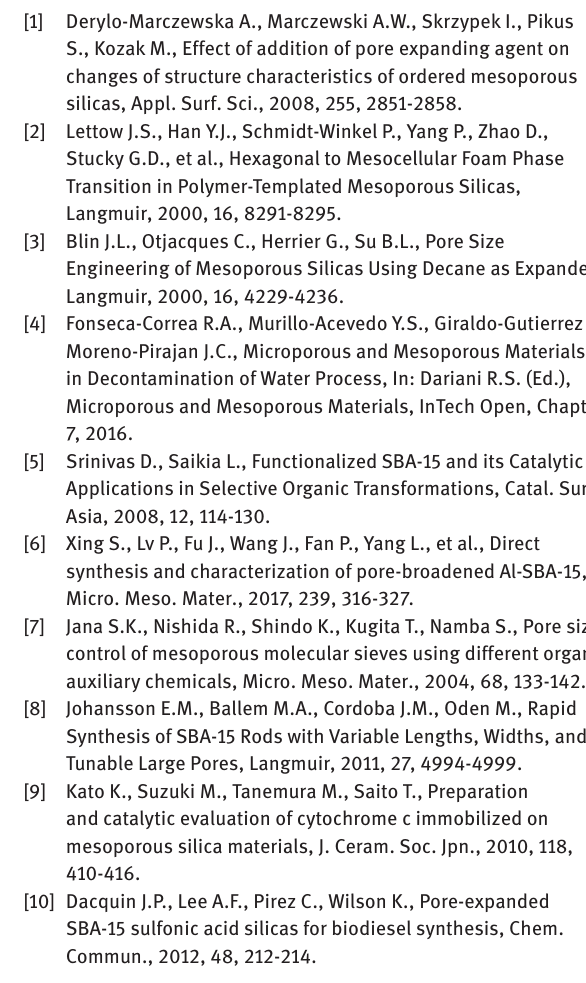
H catalyst with related solid acids for propionic acid methanol esterification. 3